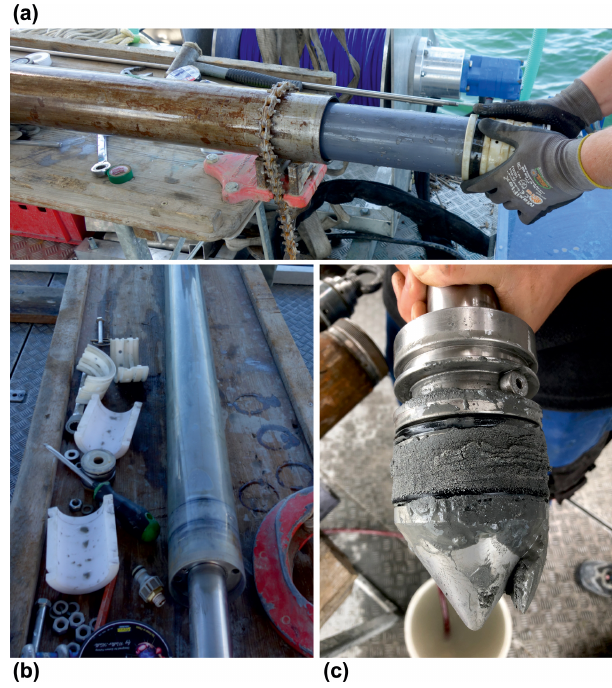
Figure 5. Opening of the coring barrel showing a 1.85m long, sediment-filled plastic liner (gray) and core catcher (white) (a) . The piston in the core-filled upper end of the liner (b) . The piston after core retrieval, with sandy sediment from Lake Constance (c)